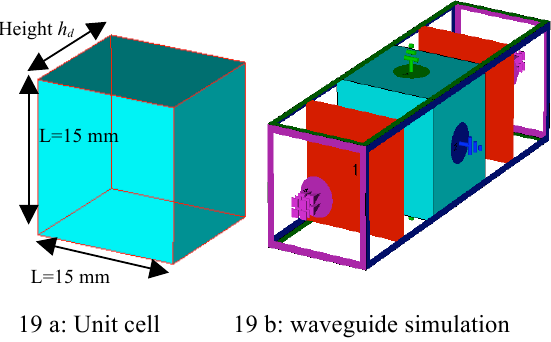
Figure 19: The detailed dimension of transmitarray unit cell and waveguide simulation.